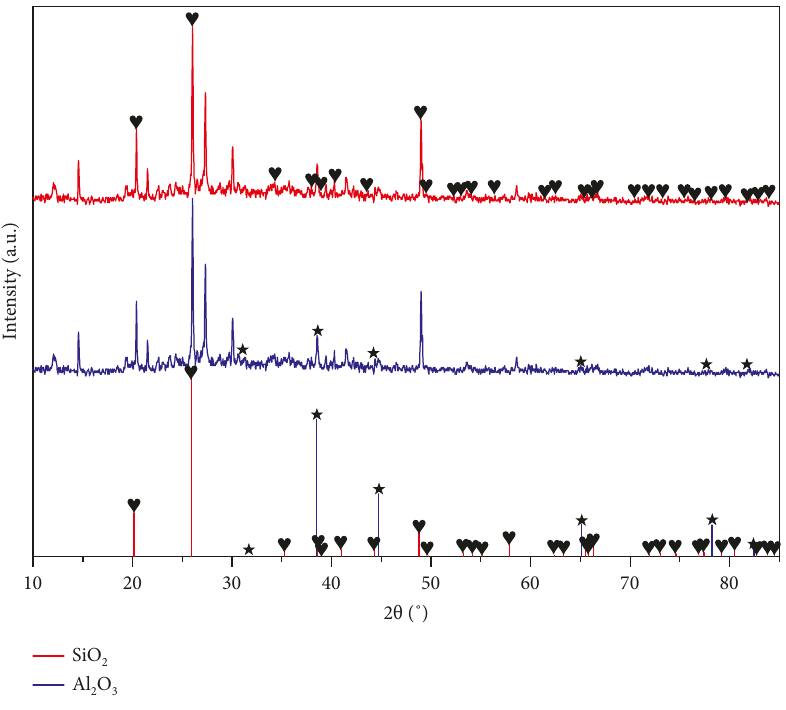
Figure 2: XRD pattern of 2# rock